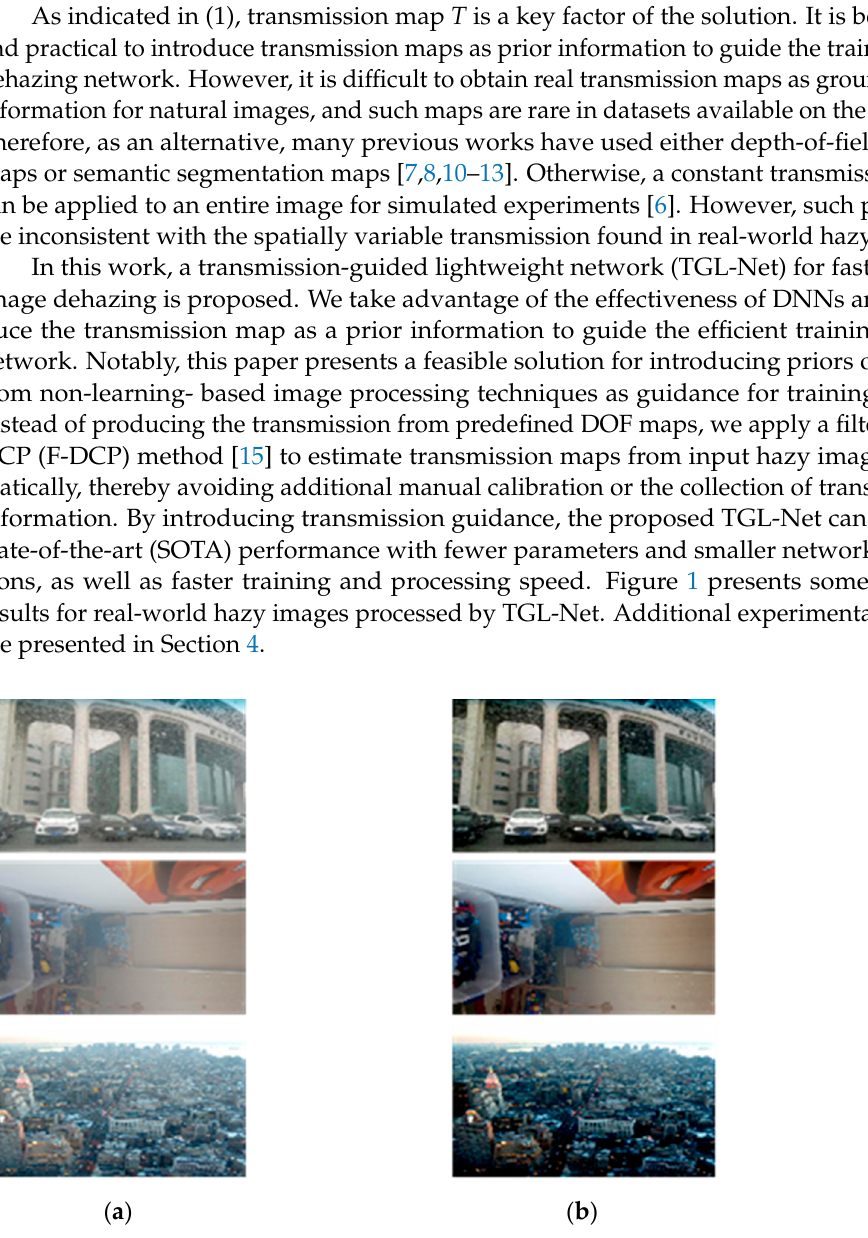
Figure 1. Sample image dehazing results using the proposed transmission-guided lightweight network (TGL-Net). ( a ) Hazy input; ( b ) dehazed output.